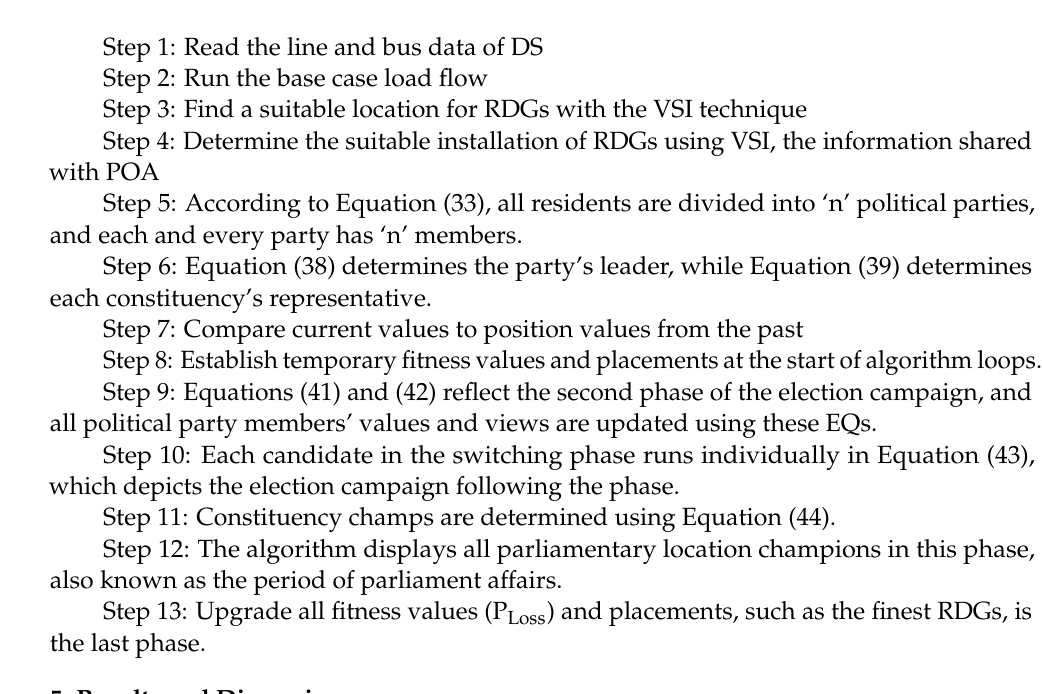
Figure 9. System power demand for 24 h. Table 2. Results for 28 Indian Real Test System considering different cases. Different Cases